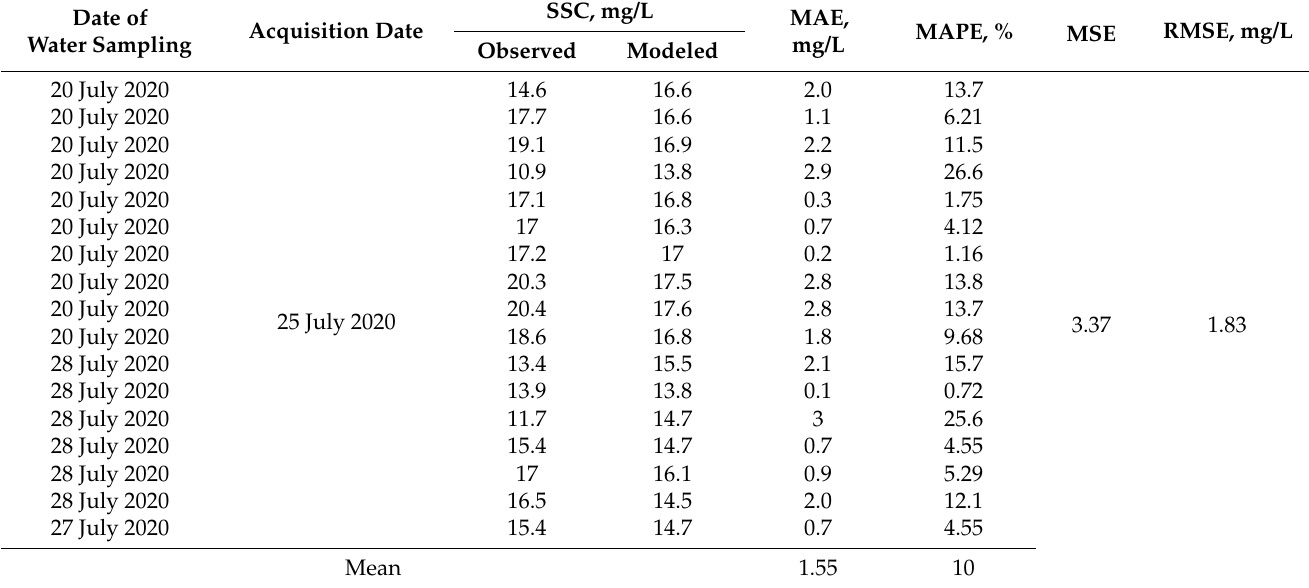
Table 4. Statistical comparisons between the modeled SSC retrieved from satellite data by the “2016-model” and measured in situ